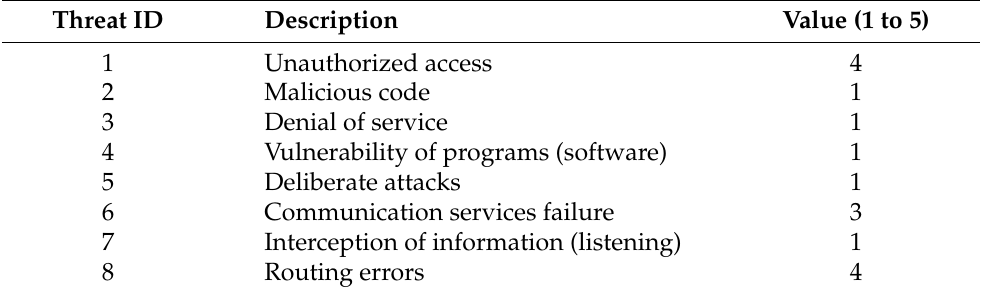
Table 7. Vulnerability evaluation simulation scenario: Threats evaluation for the network node link interface (S6,S14). Evaluation’s result (average):